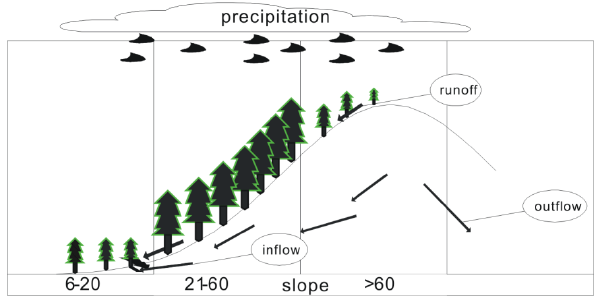
Fig. 14. Schematic diagram illustrating the processes of water re- distribution at different positions of a Figure 14. Schematic diagram illustrating the processes of water redistribution at 5 different positions of a slope. 6